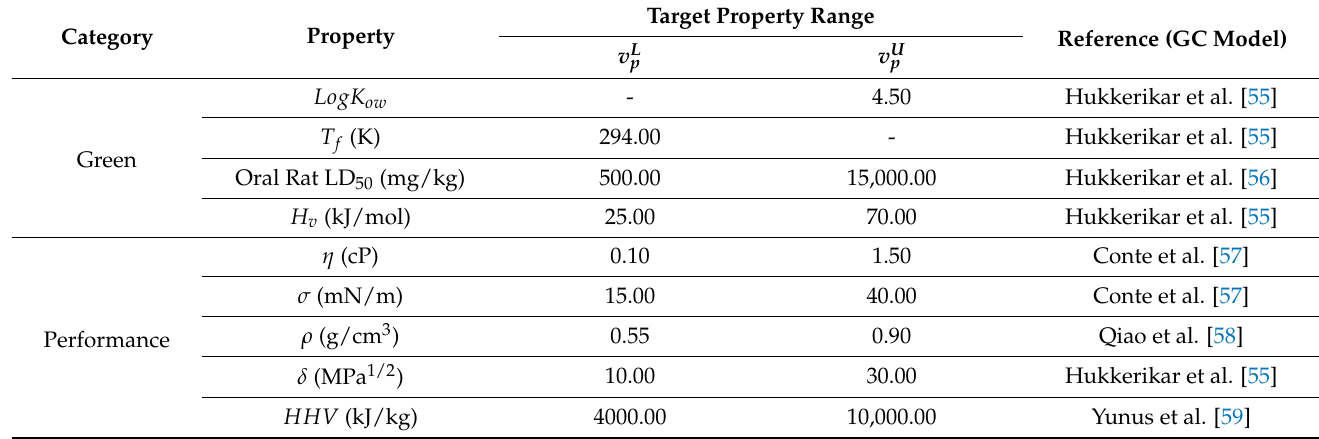
Table 3. Upper and lower limits for biofuel product